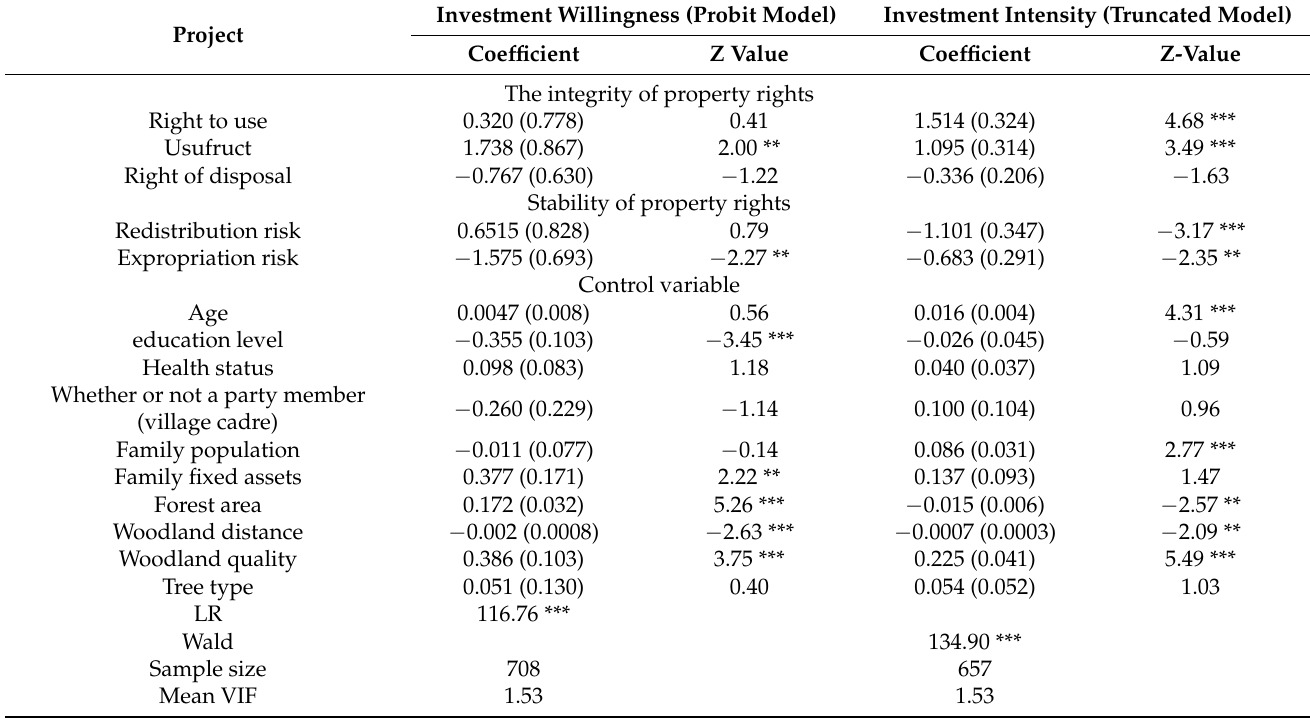
Table 2. Regression results of the impact of collective forest rights on farmers’ forestry